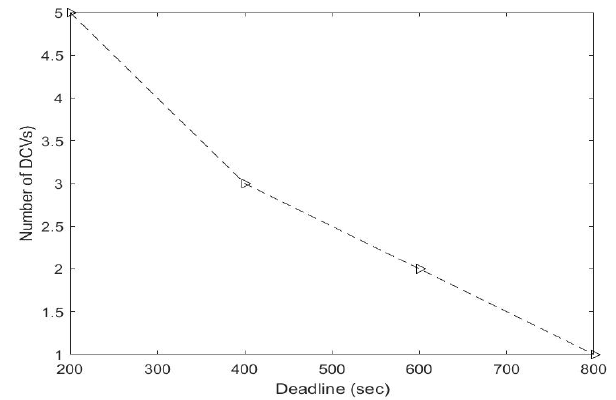
Figure 13. Number of DCVs at specific deadlines.